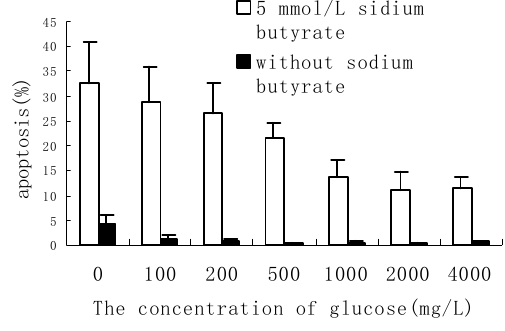
Figure 5. Treated with 5mmol/L sodium butyrate for 48 h,with the increase of concentration of glucose from 0mg/L to 2000mg/L, the apoptosis of HT-29 colonic cancer cell decreased obviously ( p <0.05). Without sodium butyrate, when the concentration of glucose was less than 200mg/L, apoptosis in a few cells was observed, but when the concentration of glucose was more than 200mg/L, the apoptosis was very